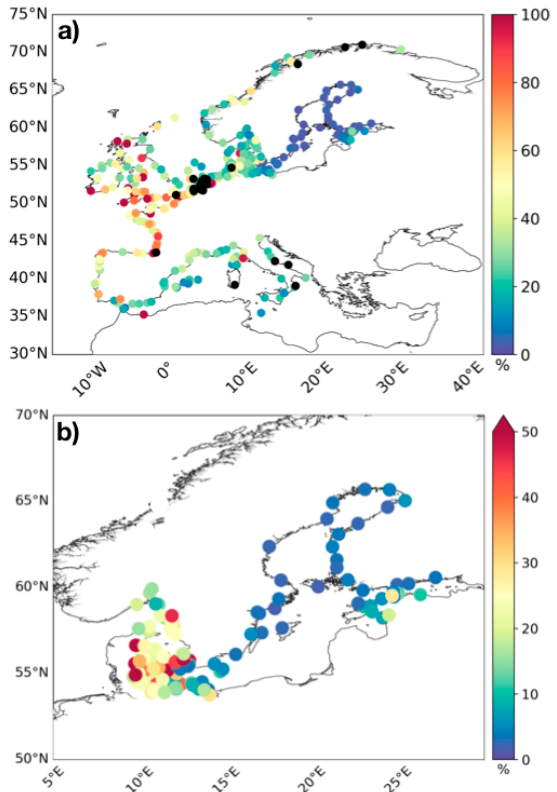
Figure 3. Spatial distribution of the mean square differences between the tide gauge and altimetry sea level from Sentinel-3A in the European coasts (panel ( a )). Black dots denote the location of the tide gauge sites rejected from the computation according with the selection criteria described in the text. Panel ( b ) shows a detailed view of the Baltic Sea region. Sea Level Anomaly (SLA) measurements without filtering have been used. Units are the percent of tide gauge variance.